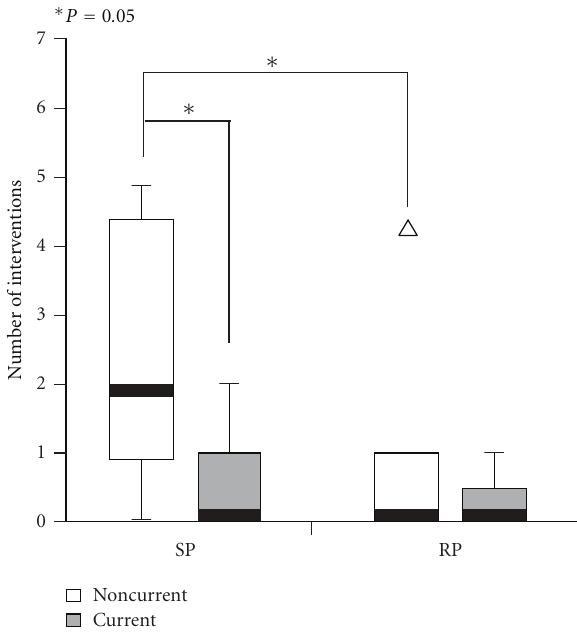
Figure 4: Total numbers of unsatisfactory and satisfactory responses to hazardous events on the seeing and blind sides for the 12 participants. The proportion of satisfactory responses to blindside hazards was significantly higher with real prisms (RP) than sham prisms